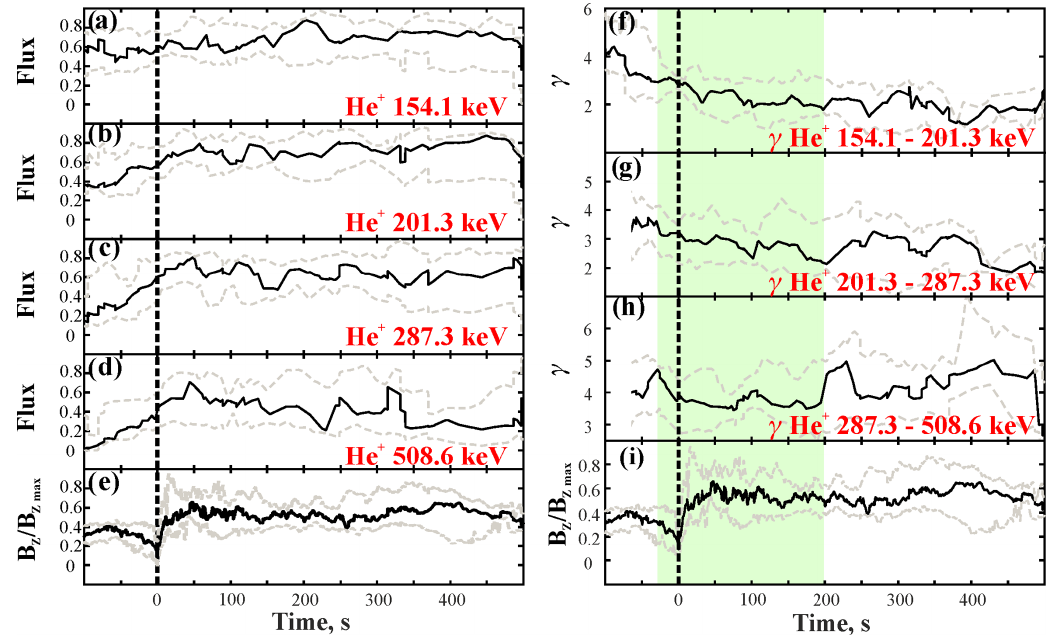
Figure 4. The epoch profiles for He + ions. The format of the figure is similar to the format of Fig. 3.